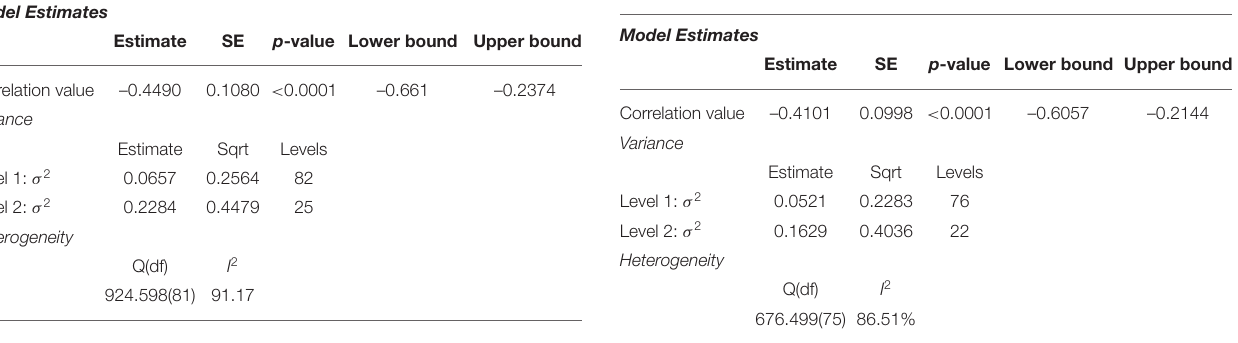
TABLE 2 | Model 1: Meta-correlation results.